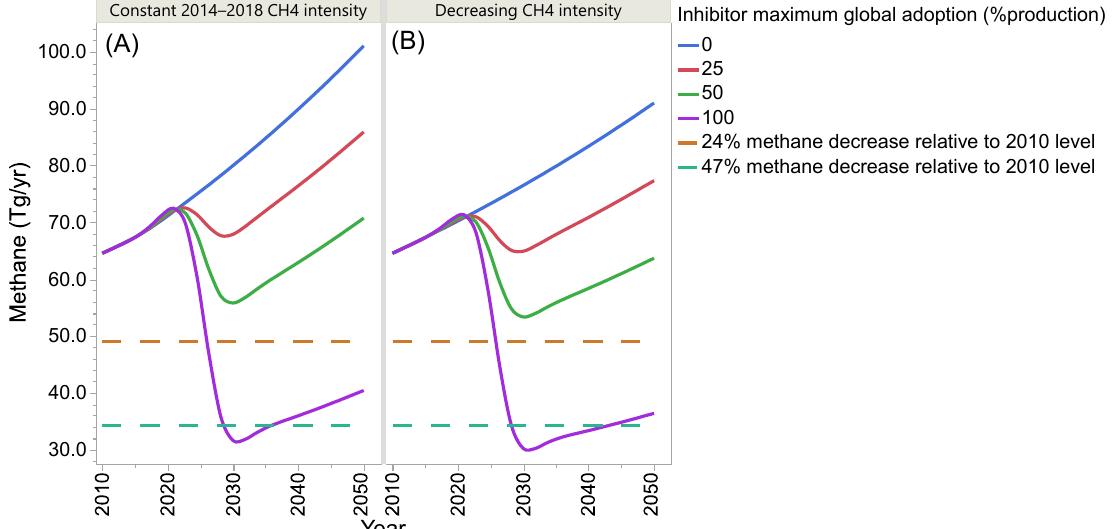
Figure 8. Predicted evolution of enteric methane (CH 4 ) emissions from global beef, lamb, and bovine milk production between 2010 and 2050 considering ( A ) constant CH 4 intensity and ( B ) declining CH 4 intensity according to Table 1. Adoption of feed additive inhibitors of methanogenesis decreasing CH 4 intensity by 60% for beef, lamb, and milk production is simulated to occur at 0, 25, 50, or 100% of global production. Decreases in enteric CH 4 emissions of 24 and 47% relative to 2010 required to maintain a global temperature increase within 1.5 °C according to different socioeconomic scenarios and climate models [15] are shown in dashed lines.